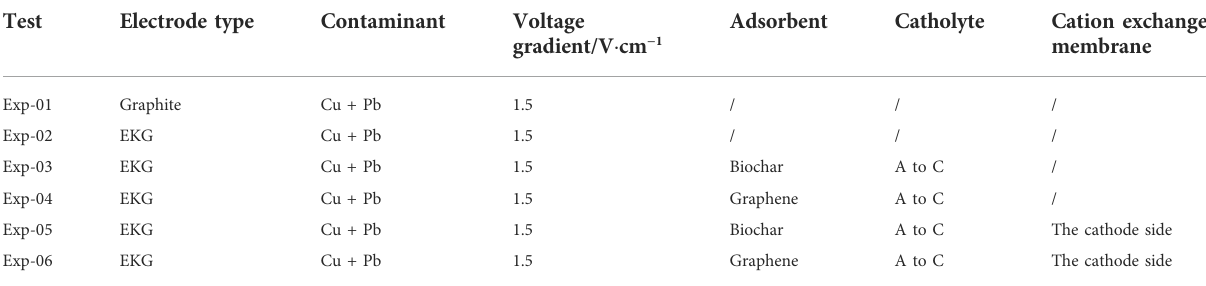
TABLE 2 Experimental design of the enhanced electrokinetic remediation of Cu- and Pb-contaminated